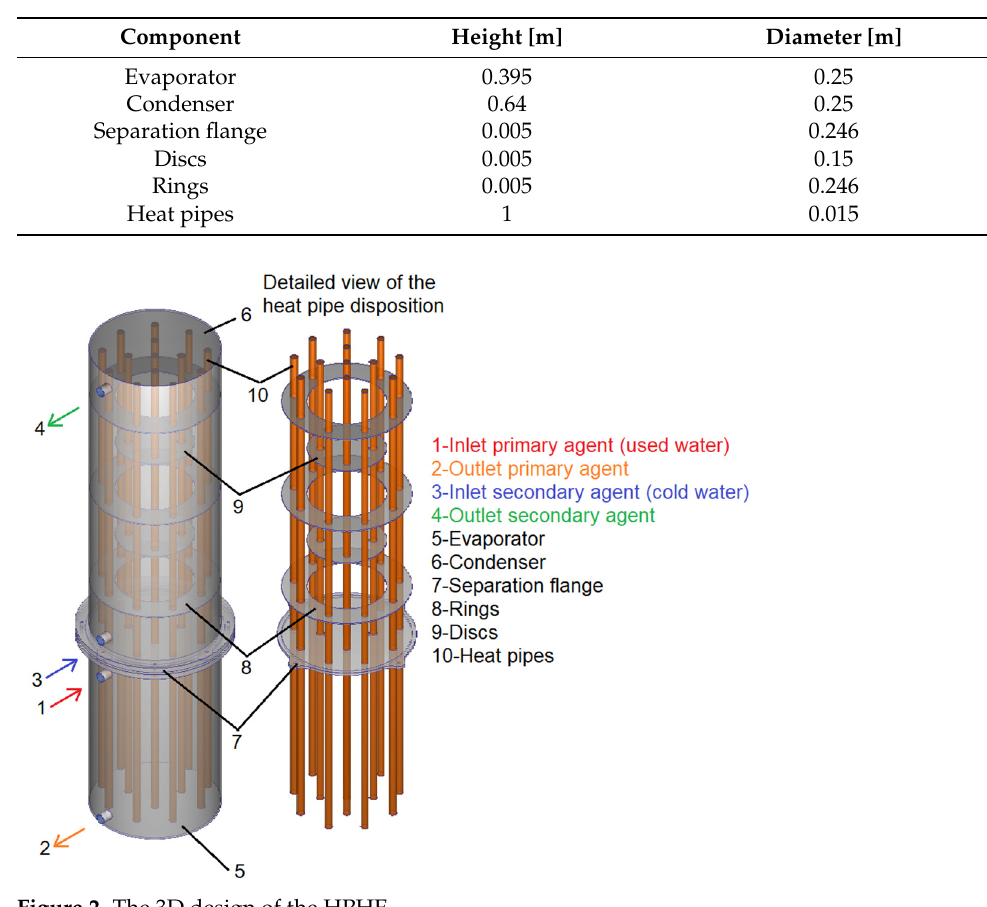
Figure 2. The 3D design of the HPHE.